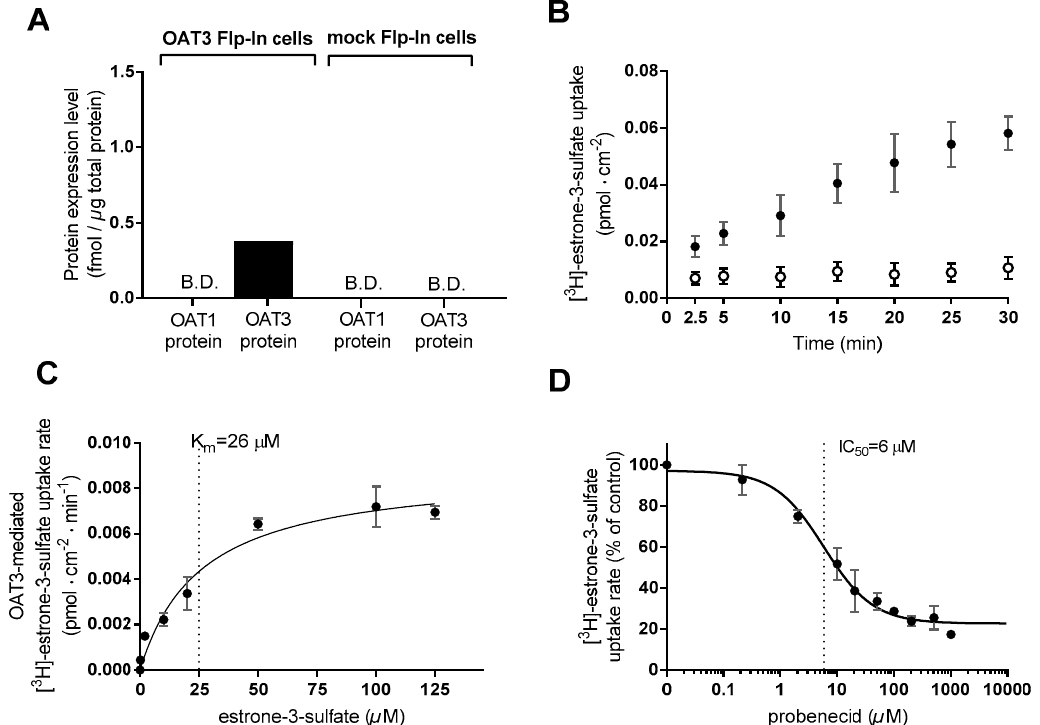
Figure 3. Functional characterization of HEK293-Flp-In cell lines stably transfected with SLC22A8 (OAT3) or empty vector (mock-transfected). ( A ) OAT1 and OAT3 protein expression levels in HEK293-Flp-In OAT3 cells and HEK293-Flp-In mock cells. B.D., below the detection limit. ( B ) Time-dependent uptake of 0.02 µM (1 µCi/mL) [ 3 H]-estrone-3-sulfate (E3S) in HEK293-Flp-In OAT3 expressing cells (closed circles) and HEK293-mock cells (open circles). ( C ) The OAT3-mediated uptake rate of 0–125 µM E3S spiked with 0.02 µM [ 3 H]-E3S in HEK293-Flp-In OAT3 cells. ( D ) Effect of 0.02–1022 µM probenecid on the uptake rate of 0.02 µM [ 3 H]-E3S in HEK293-Flp-In OAT3 cells ( D ). Each data point represents the mean±SEM of replicates in three cell passages ( B, C, D ) obtained at Lab. 2 or results from one cell passage ( A ) obtained at Lab. 1.